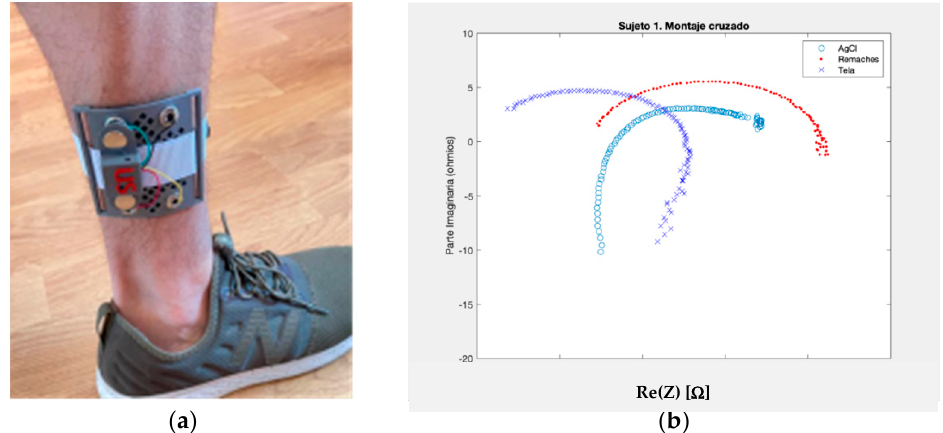
Figure 3. Setup and circuits used for ankle leg test ( a ). Wessel diagram for a BI spectroscopy in leg using Ag/AgCl electrodes, stainless electrodes, and textile electrodes ( b ).